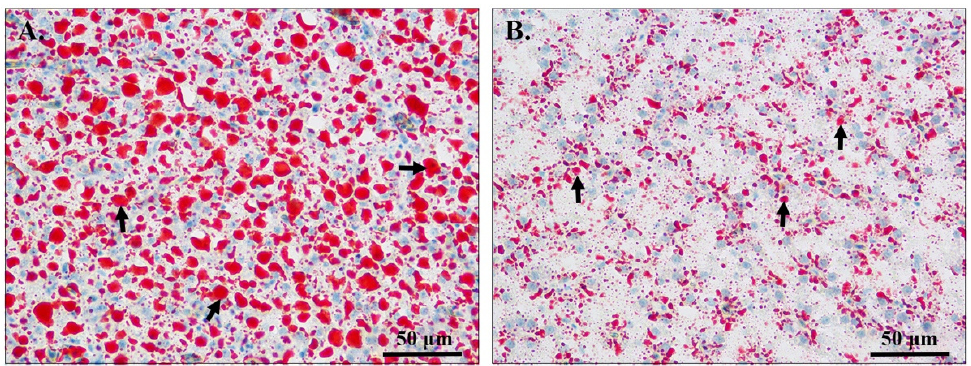
Figure 1. Oil red O staining of liver tissues in genetically improved farmed tilapia (GIFT) fed a high-fat diet (HFD) or normal-fat diet (NFD) for 56 days. Bar = 50 µ m. ( A ) Liver status of GIFT in the HFD group; ( B ) Liver status of GIFT in the NFD group. Black arrows indicate lipid droplets. Table 2. Area of lipid droplets in the liver of GIFT fed a HFD or NFD for 56 days. HFD Group NFD Group lipid droplet (object/total, %) 0.28 ± 0.01 * 0.10 ± 0.01 * means significant difference ( p < 0.05) between HFD and NFD group. ( n =